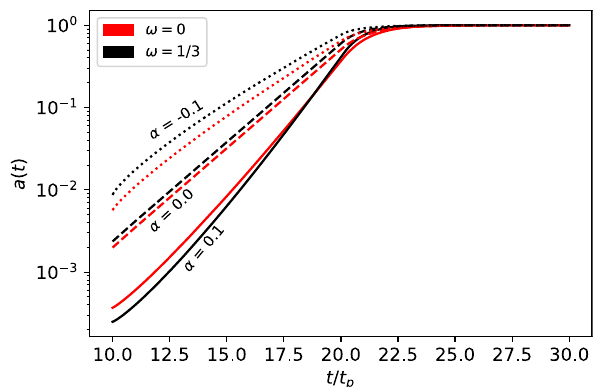
Fig. 2 Some solutions to the delayed Friedmann equation due to a delay τ = 10 t p , where t p is Planck time. The inflationary period lasts for one delay unit (in this figure, from t = 10 t p to t = 20 t p ) before the scale factor transitions to a decelerated evolution